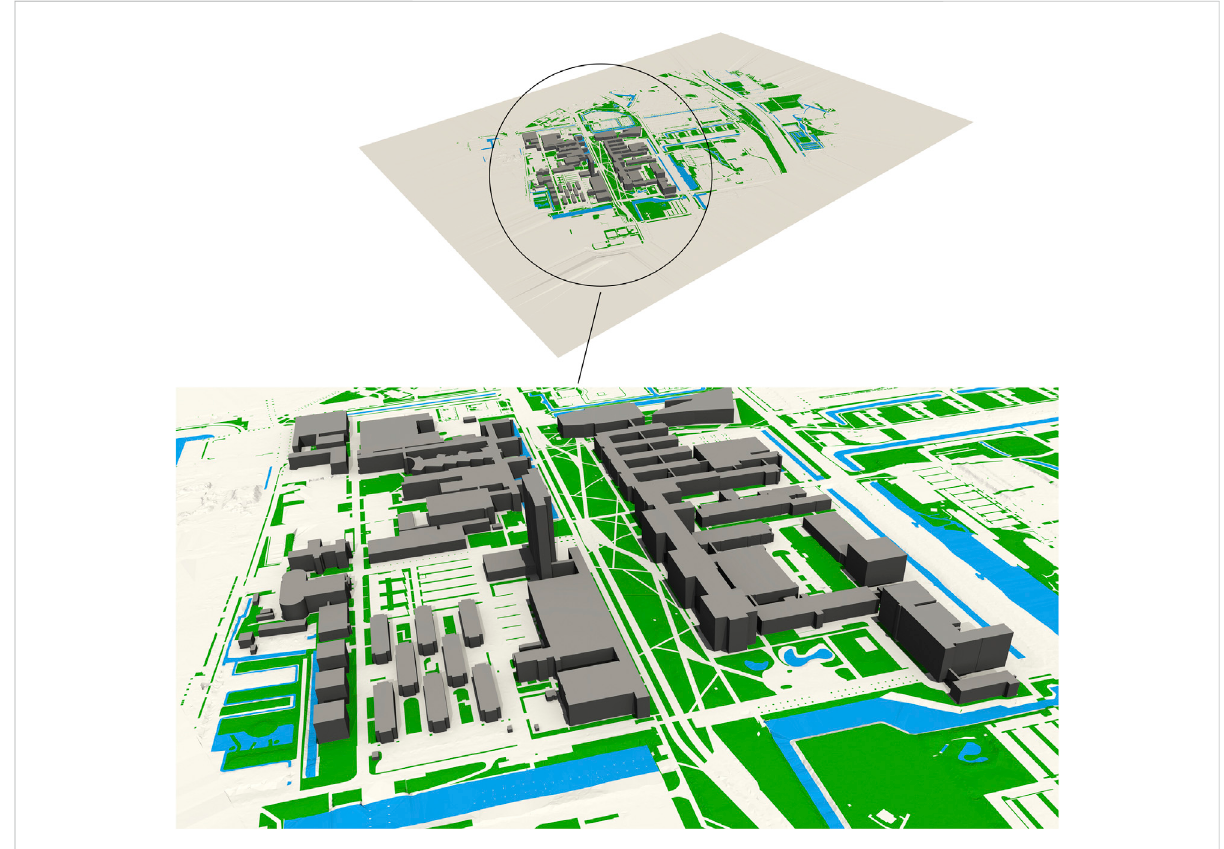
FIGURE 12 Reconstructed geometry of TUD campus with water and vegetation surface